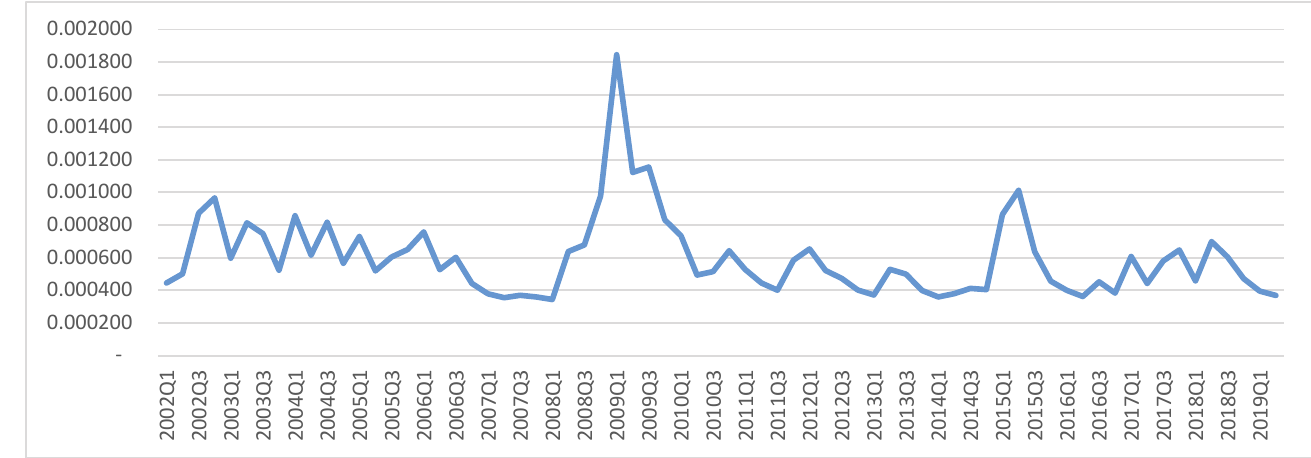
Fig. 1. Volatility of the real effective exchange rate in Vietnam in the period of 2002 -